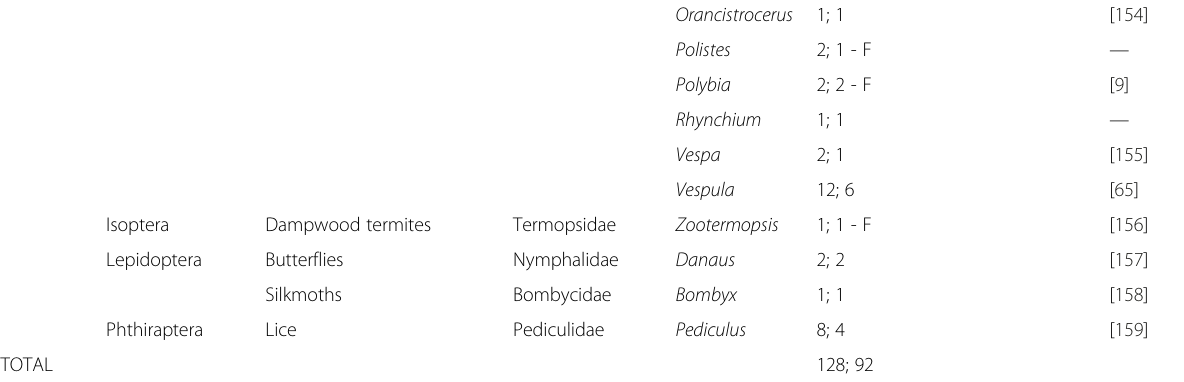
Table 1 Hyaluronidases from the phylum Arthropoda